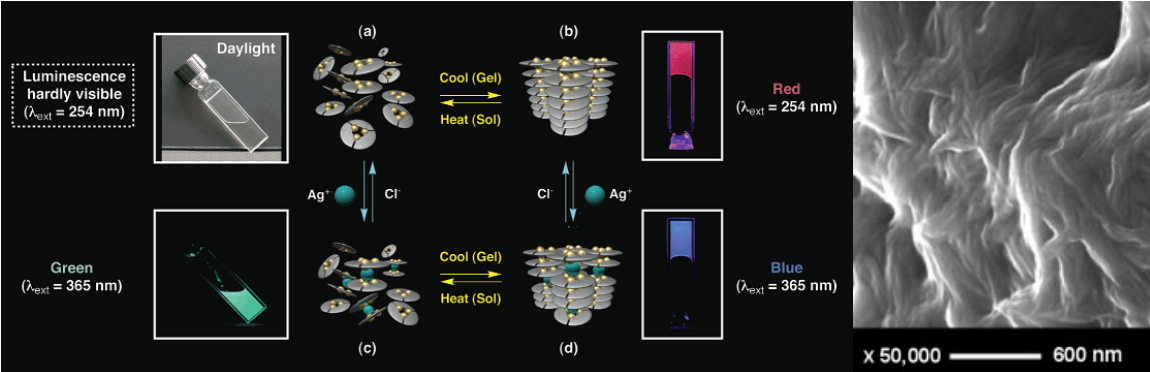
Figure 1. Gold organogelators reported in the literature.